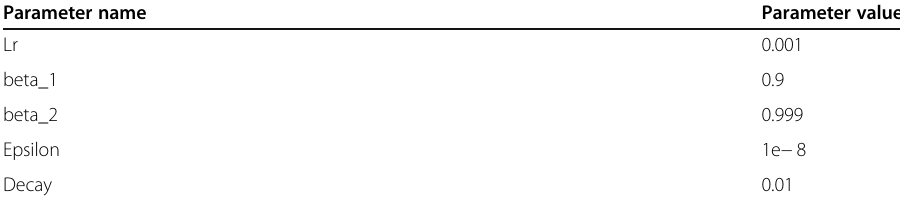
Table 4 Adam optimizer